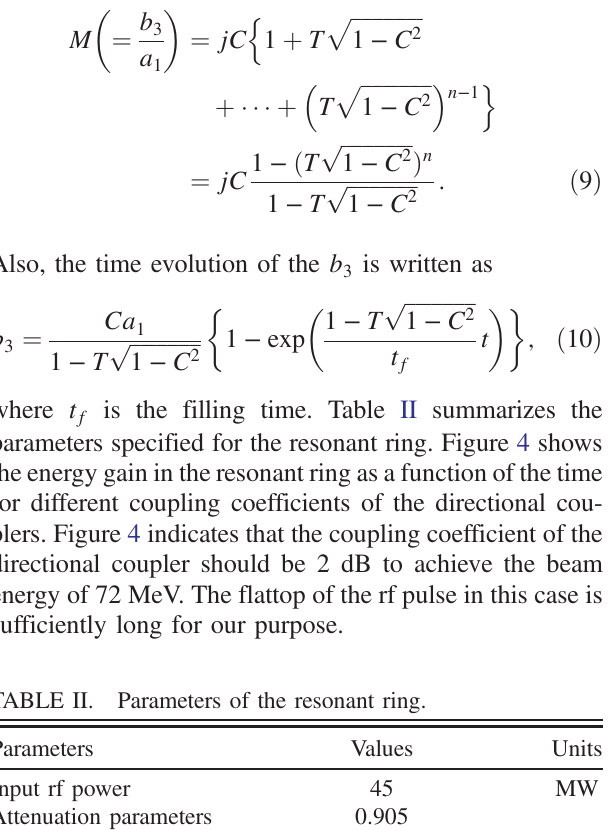
FIG. 5. Drawing of PXR